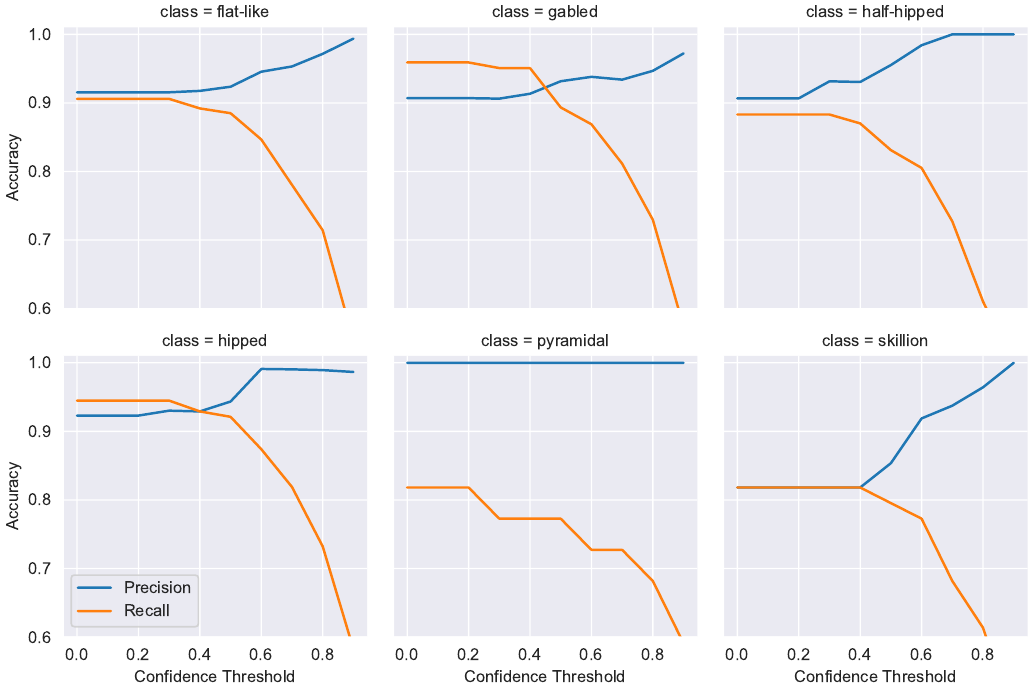
Figure 14. Test Set 1 confidence threshold impact on precision and recall for multiple classes.